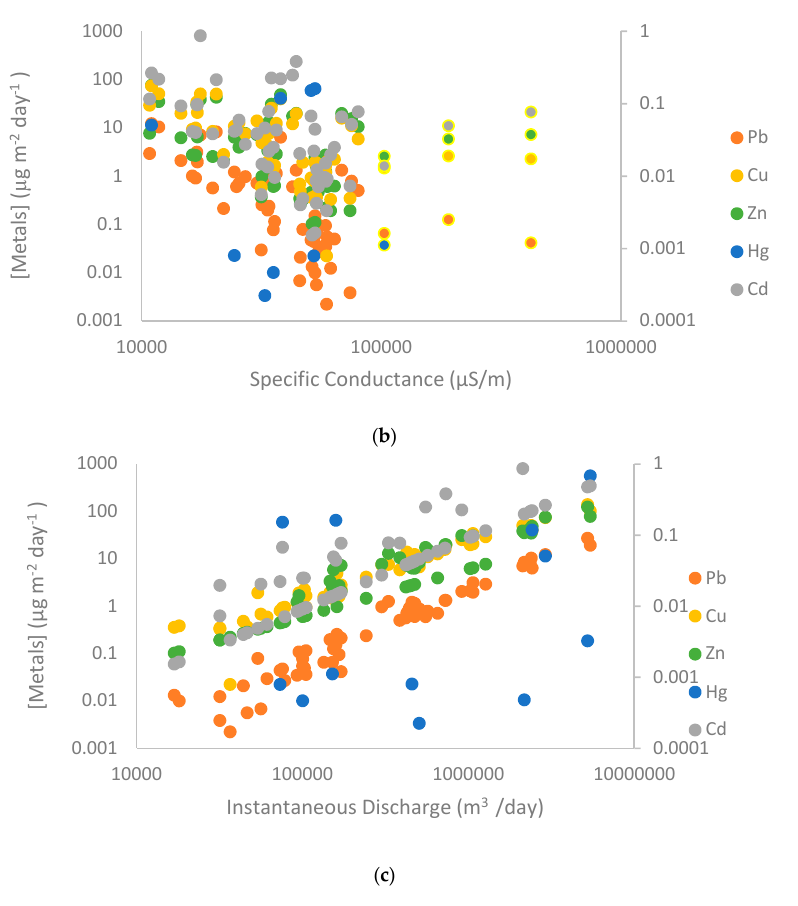
Figure 5. Relationships between metal fluxes and turbidity ( a ), specific conductance ( b ), and instantaneous discharge ( c ) for the Rock Creek watershed.